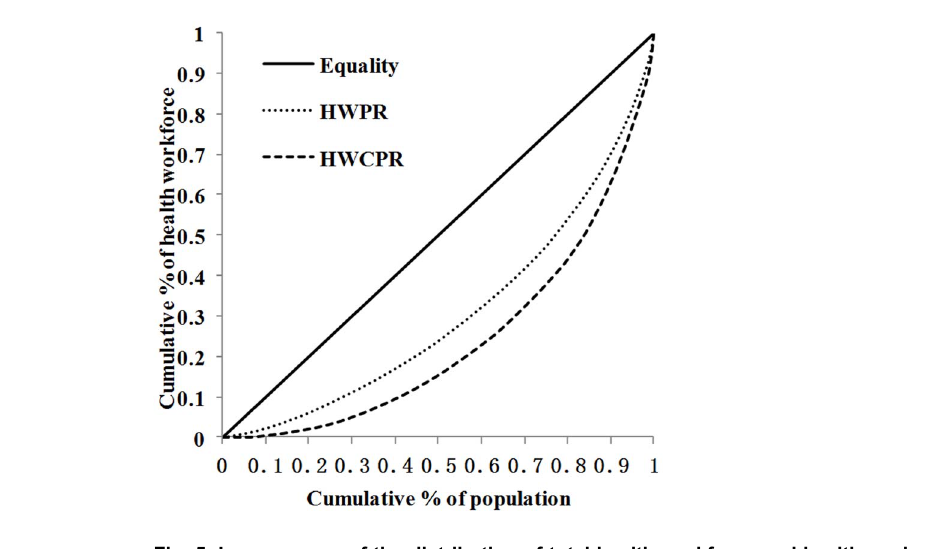
Fig. 5. Lorenz curve of the distribution of total health workforce and health workers educated to college level or above per 10000 population ratio in Chinese CHS. HWPR: health works per 10000 population ratio; HWCPR: health workers educated to college level or above per 10000 population ratio.